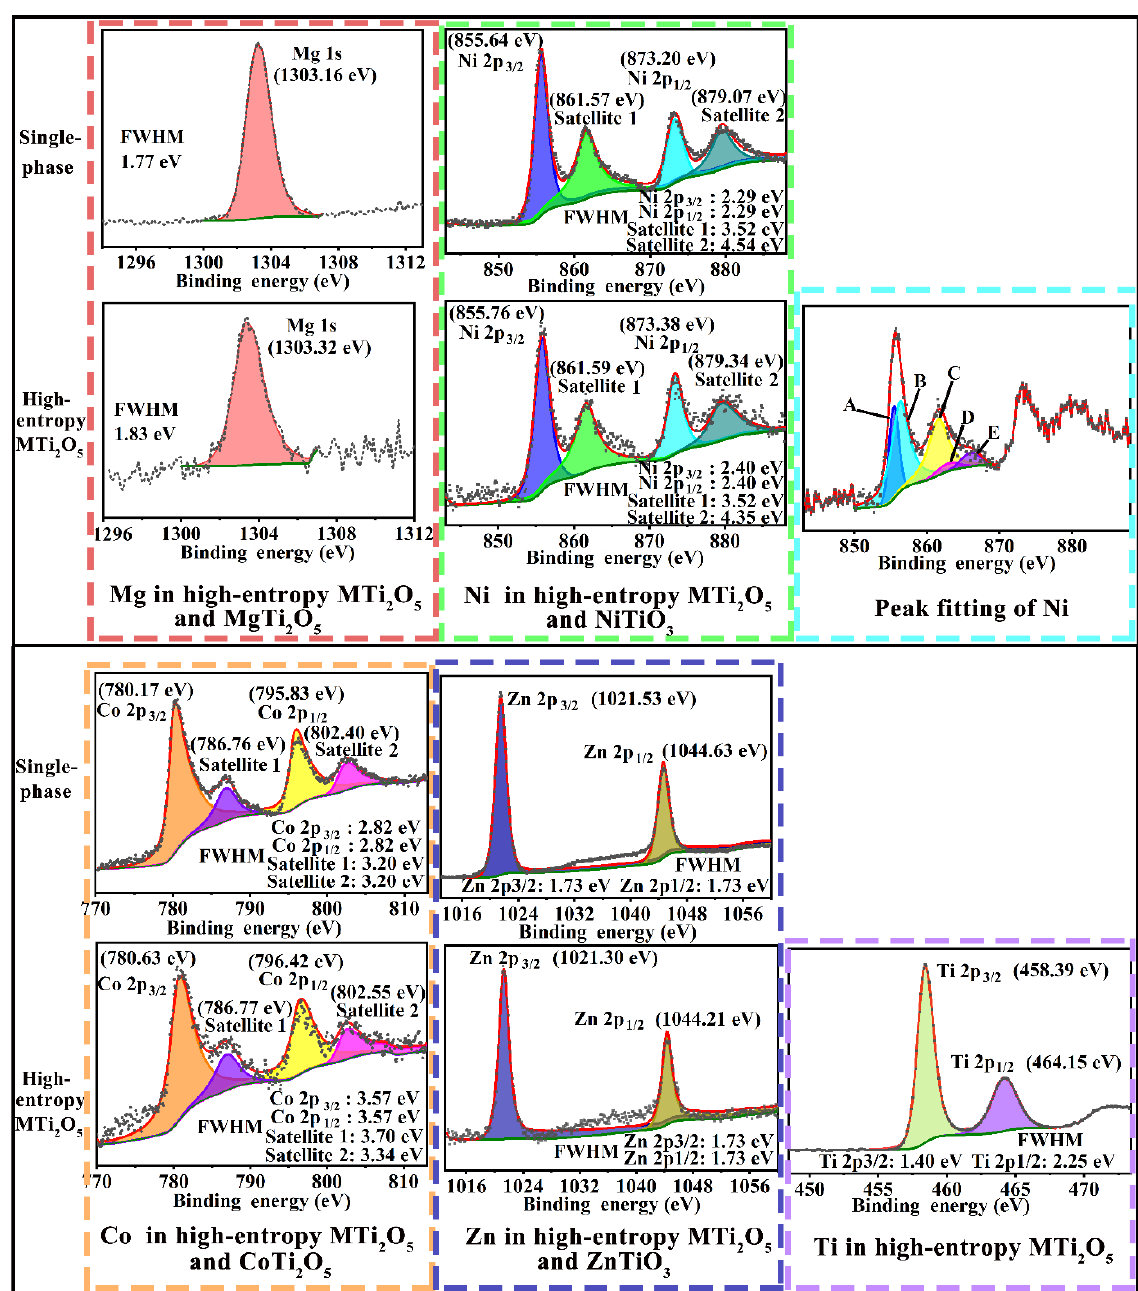
Fig. 8 High-resolution XPS spectra of Mg 1s, Co 2p, Ni 2p, Zn 2p, and Ti 2p in high-entropy (Mg,Co,Ni,Zn)Ti 2 O 5 and corresponding normal pseudobrookite ceramics; and peak fitting of Ni 2p 3/2 and satellite peak of high-entropy (Mg,Co,Ni,Zn)Ti 2 O 5 . FWHM represents the full width at half